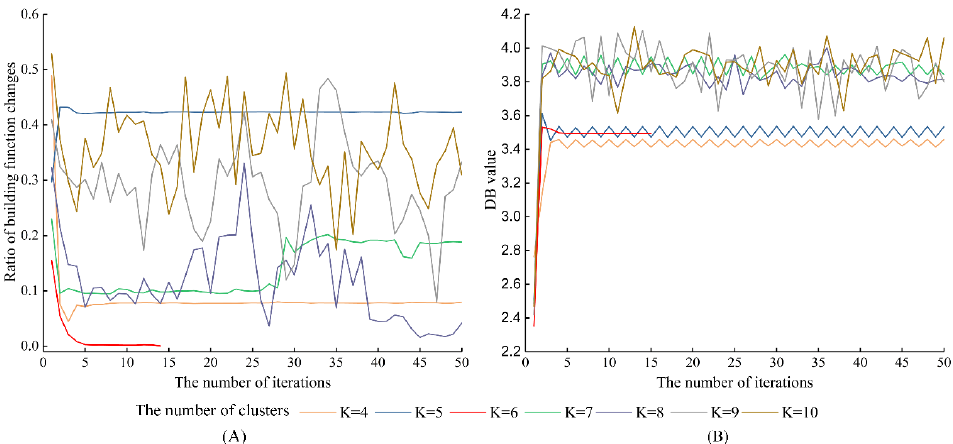
Figure 6. Determination of the optimal K value (A) The ratio of the building function changes as the the number of iterations increases under di ff erent K values; ( B ) the DB value as the number of number of iterations increases under different K values; (B) the DB value as the number of iterations iterations increases.